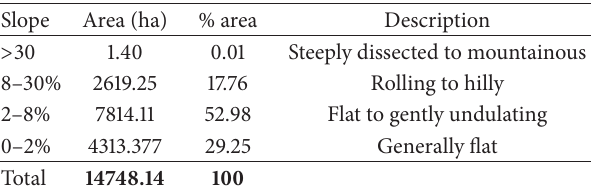
Table 5: Slope classification.